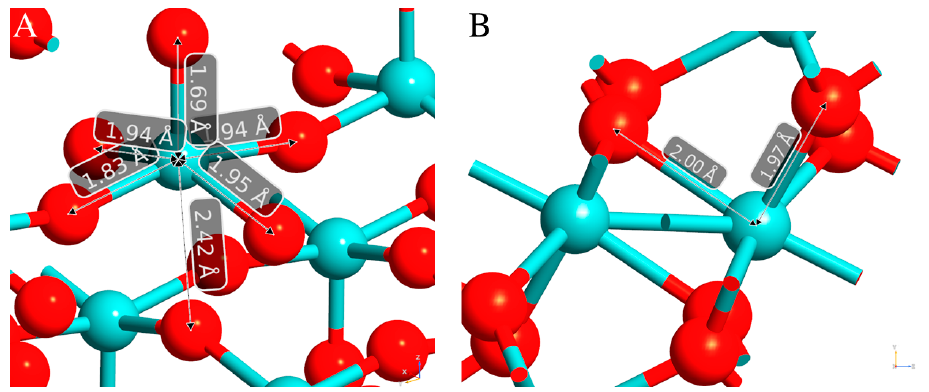
Figure 2. Bond lengths of MoO 3 ( A ) and MoO 2 ( B ). Mo atoms are depicted in light blue, while O are reported in red.